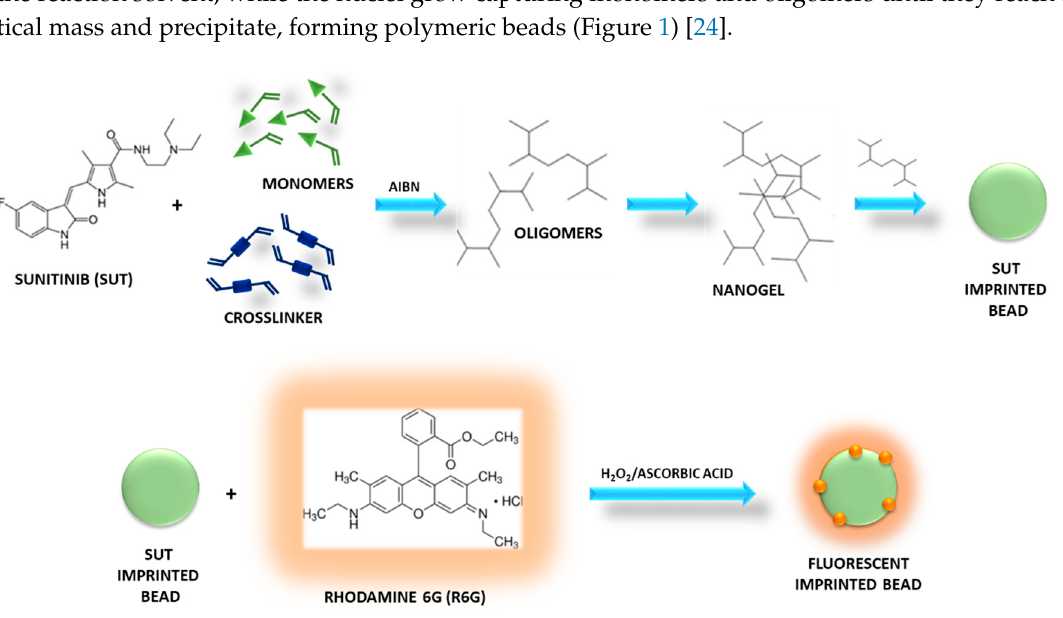
Figure 1. Synthesis of Sunitinib (SUT) imprinted beads grafted with Rhodamine 6G.